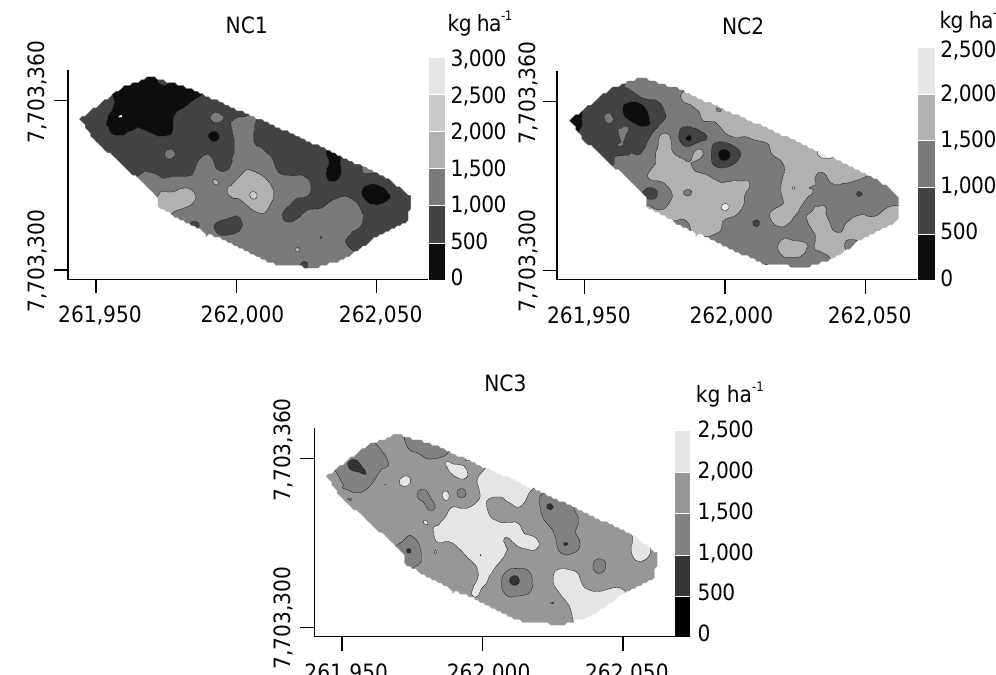
Figure 5. Spatial distribution of liming needs (NC) in the three studied crops.